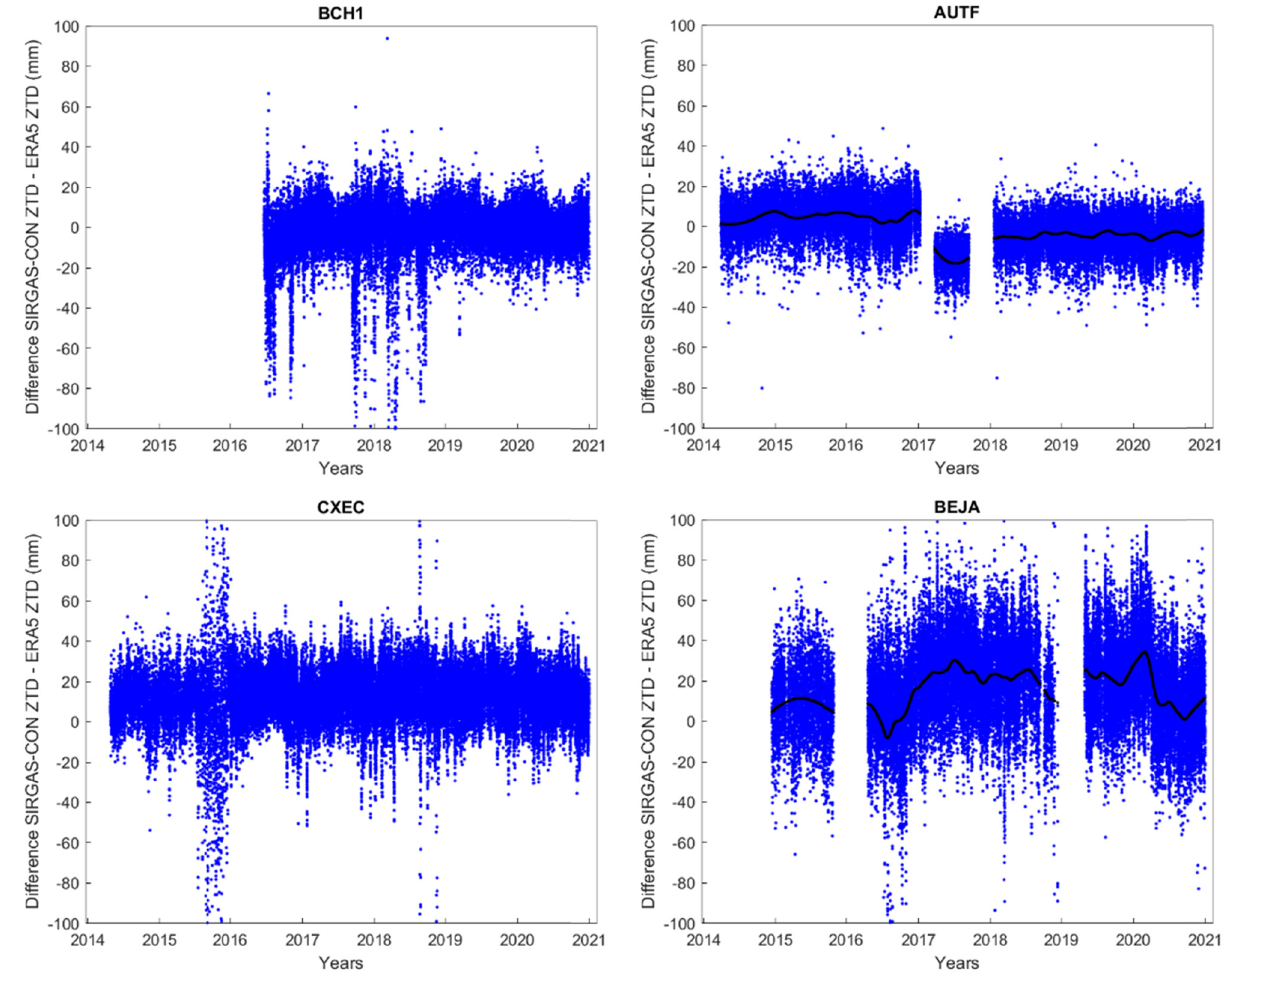
Figure 8: SIRGAS - CON ZTD and ERA5 ZTD di ff erences for stations ( a ) BCH1 and ( b ) CXEC.